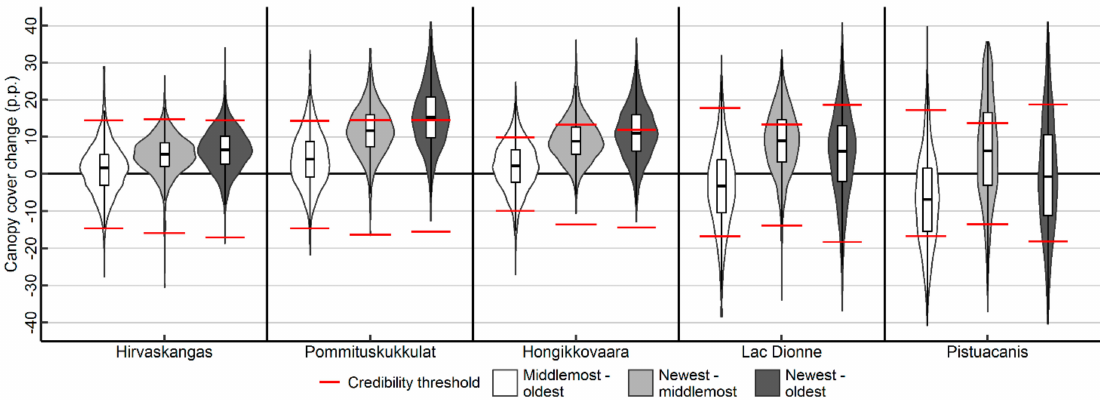
Figure 4. The canopy cover change distributions for the 0.1-ha cells for the first study interval (white), for the second study interval (light grey) and for the whole study interval (dark grey) in each landscape as percentage points (p.p.). The violins indicate the distribution of the change values in the given landscape and the study interval. The boxplots within the violins indicate the interquartile range of the data. The bottom boxplot whisker indicates the Q1 − 1.5 × interquartile range, and the topmost whisker the Q3 + 1.5 × interquartile range. The red lines are the credibility thresholds. The cells above the topmost threshold have credible positive canopy cover change, and the cells below the bottom threshold have credible negative